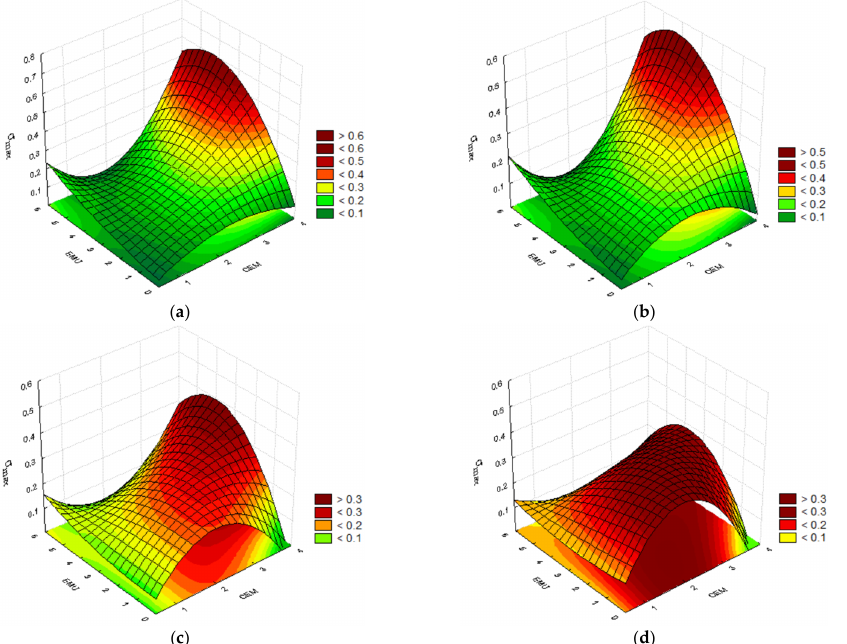
Figure 7. Plots for the stress at break σ masx at the temperature of 20 °C, taking into consideration the cement and bitumen emulsion contents and the polymer modifier content of ( a ) 0.0%; ( b ) 0.5%; ( c ) 2.0%; and ( d ) 3.5%. In the recycled mixture with no polymer modifier, i.e., a typical mineral–cement–emulsion mix, the highest stress at break σ max occurs at high cement contents. The addition of polymer into the recycled mixture and a gradual increase in its content allows us to obtain higher and more uniform results of stress at break σ max in a test conducted at 20 °C, especially in the case of polymer modifier content of 3.5%. An increase in the modifier content thereby allows us to reduce the cement and bitumen emulsion contents in the mixture without deteriorating the material’s property, while maintaining the required durability.